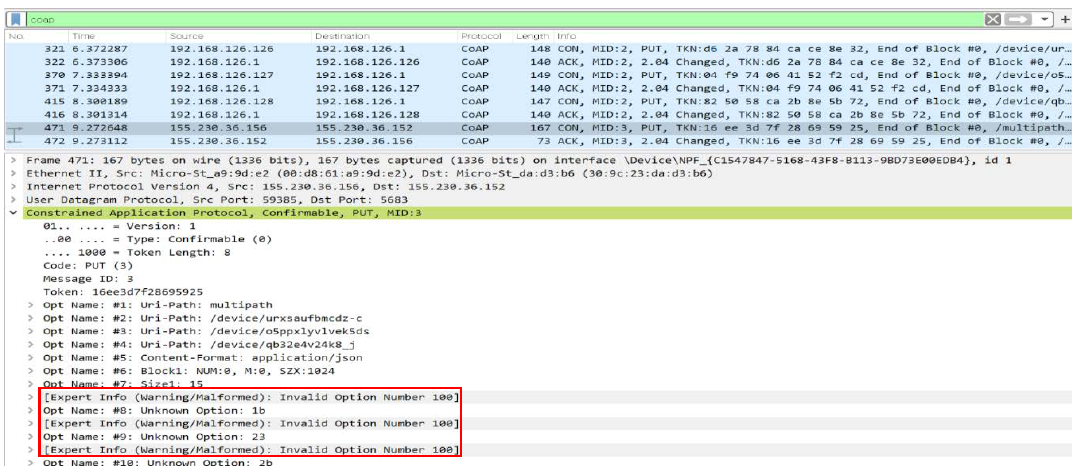
Figure 23. Packet capturing results for multiple URI communication.